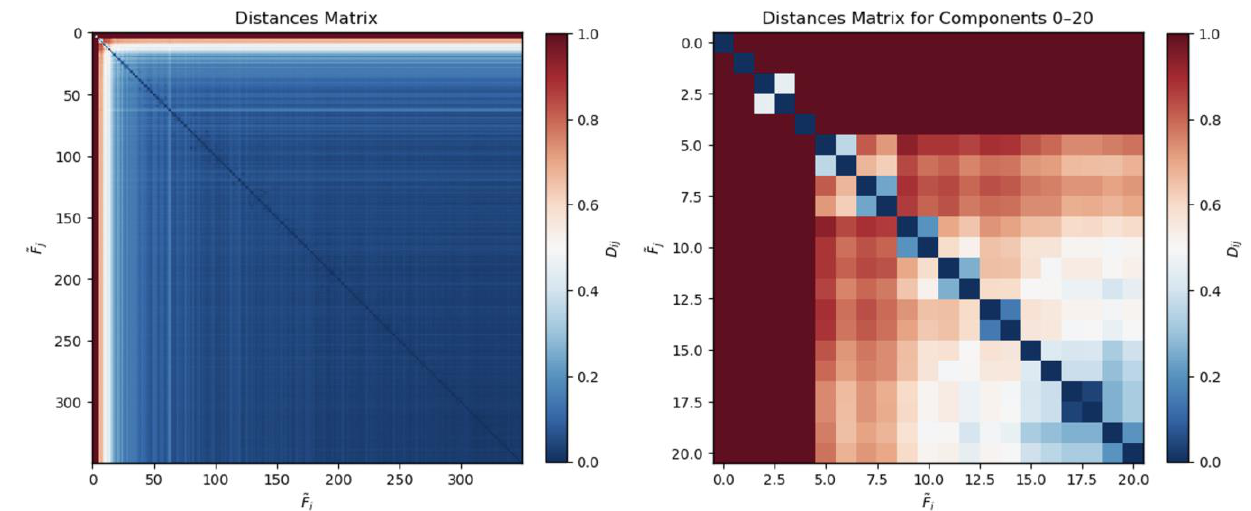
Figure 9. Distance matrix based on the Frobenius norm for phase A of the bearing without faults, on the left for the complete set of components (350) and on the right for the investigated set of informative components (20).